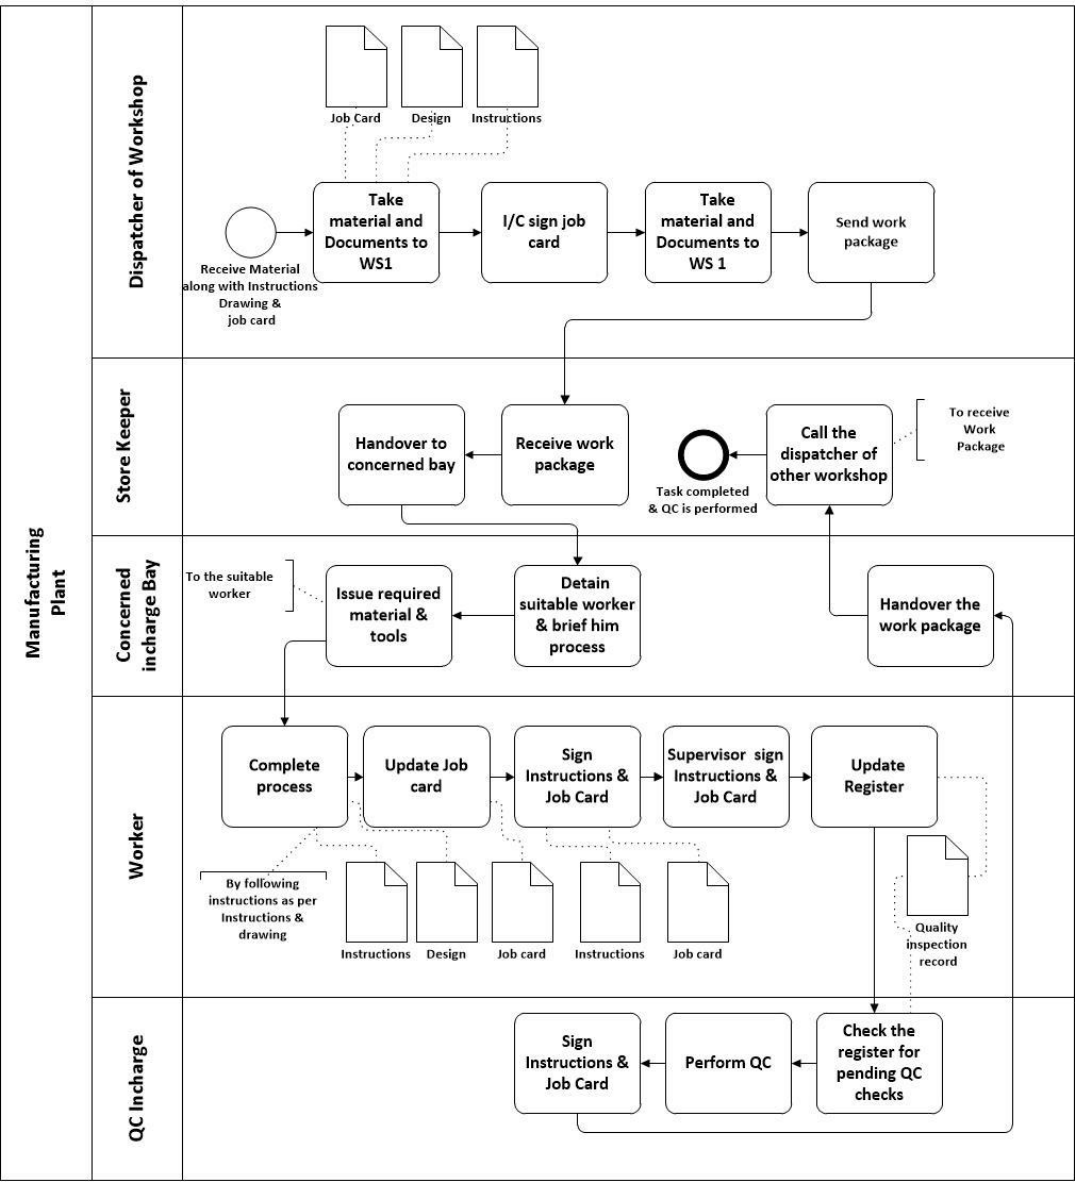
Figure 9. BPMN example of receiving a task from Workshop 1 and handing it to the concerned bay.